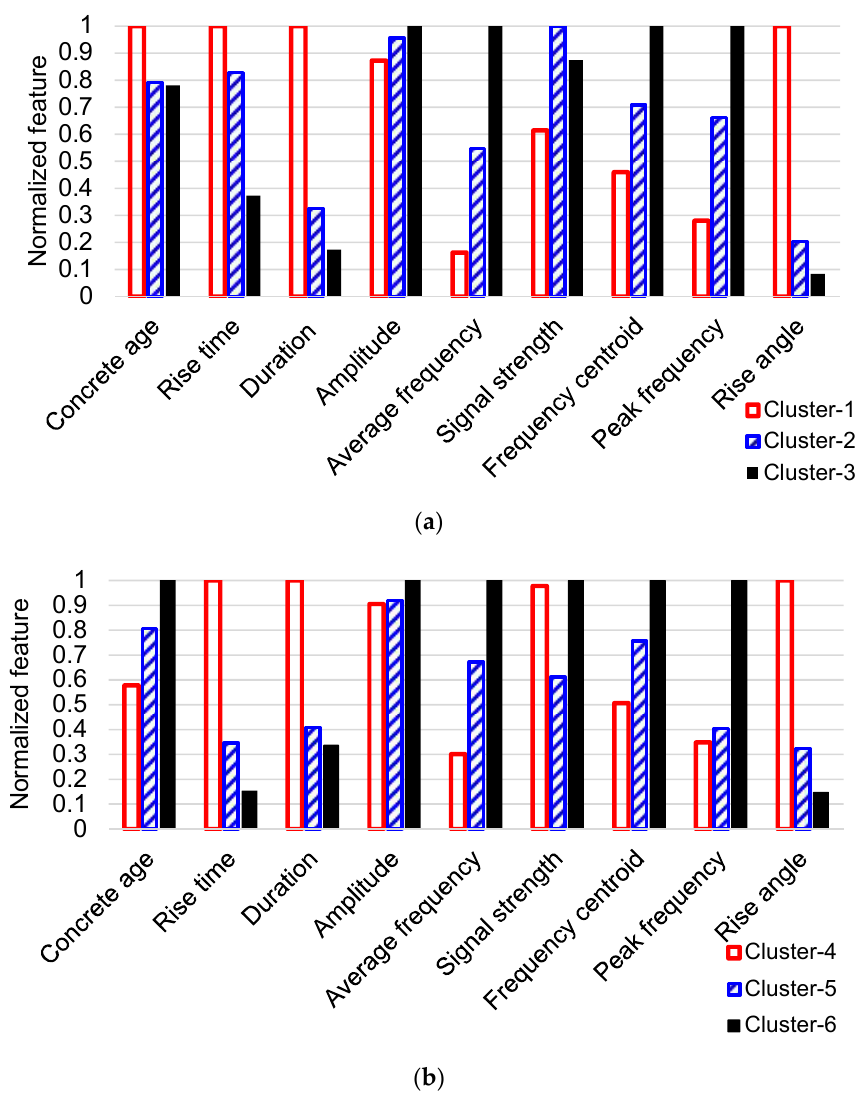
Figure 10. Normalized signal features. ( a ) Confined specimen; ( b ) Unconfined specimen.